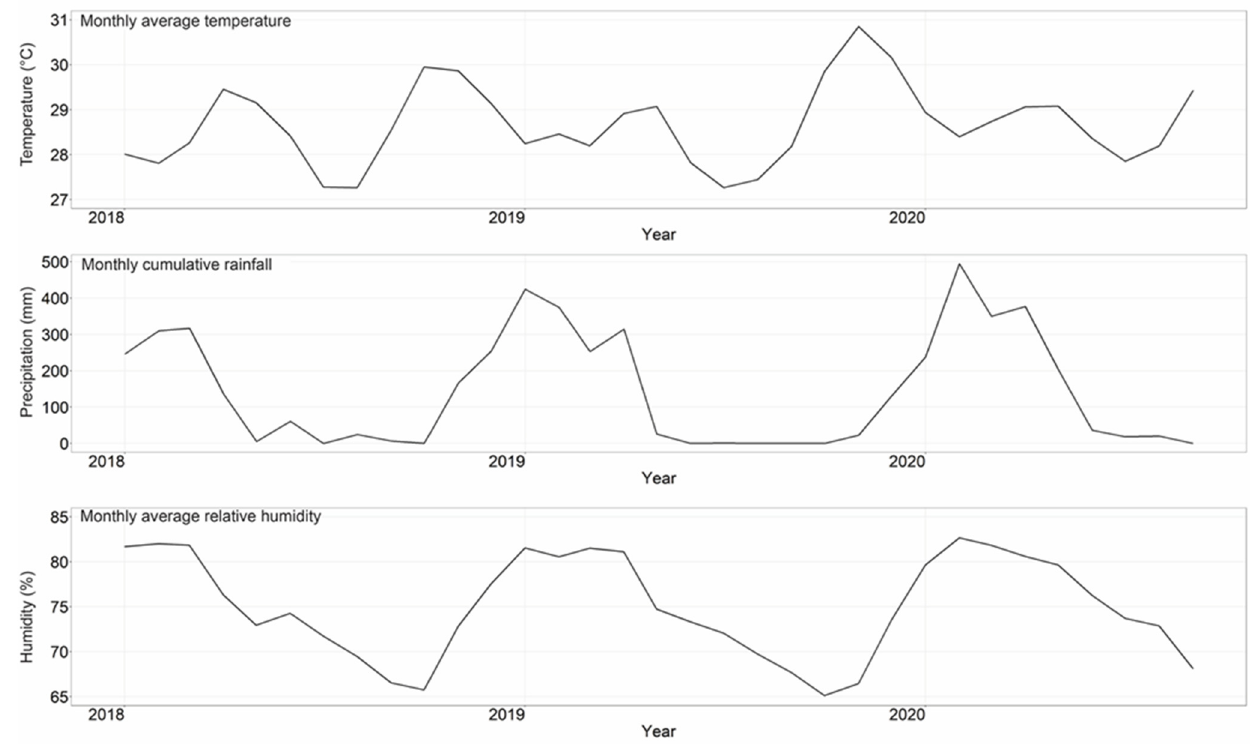
Figure 3. Monthly averages of temperature (°C), precipitation (mm), and relative humidity (%)